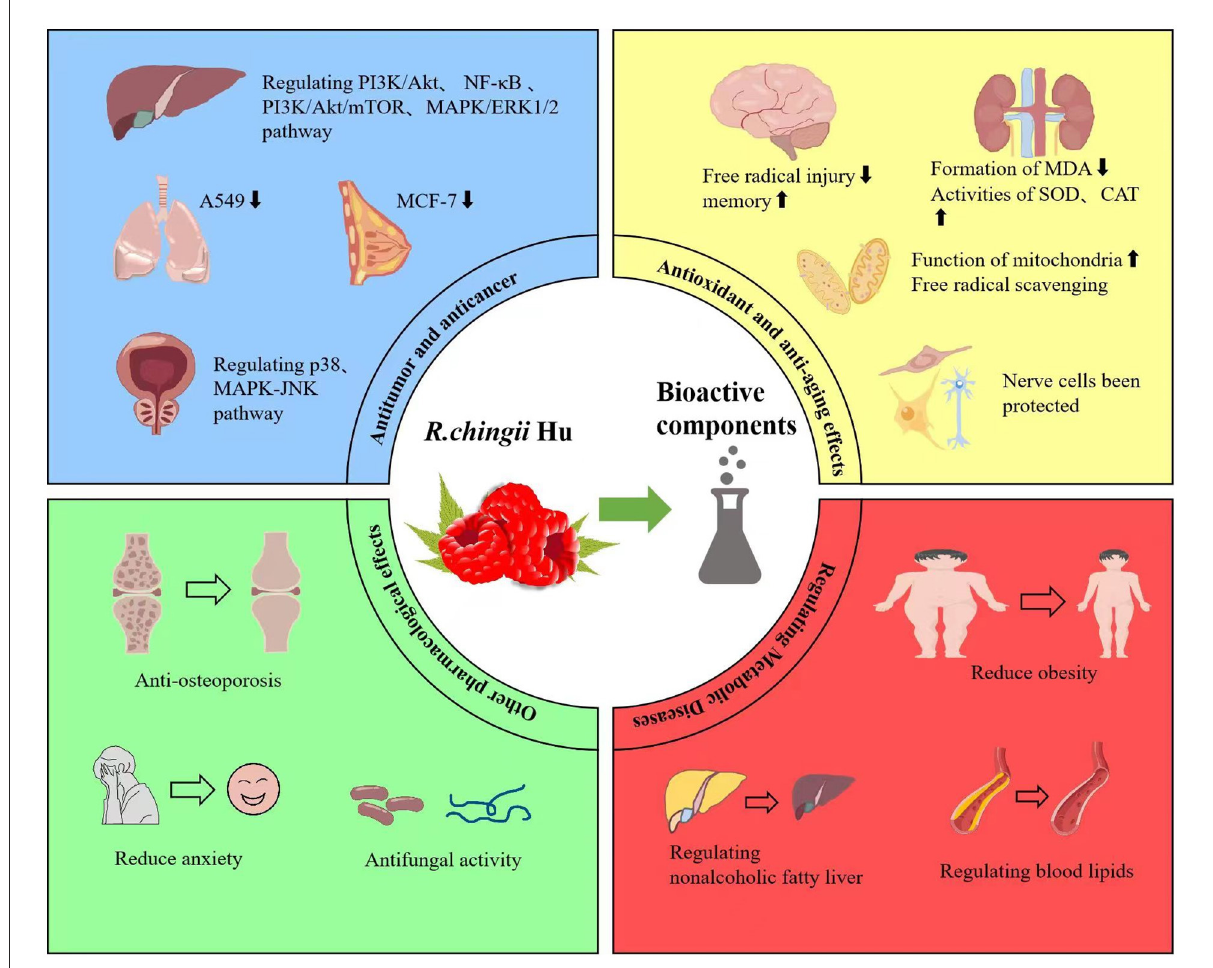
FIGURE4 The most important pharmacological effects and potential mechanisms of R. chingii